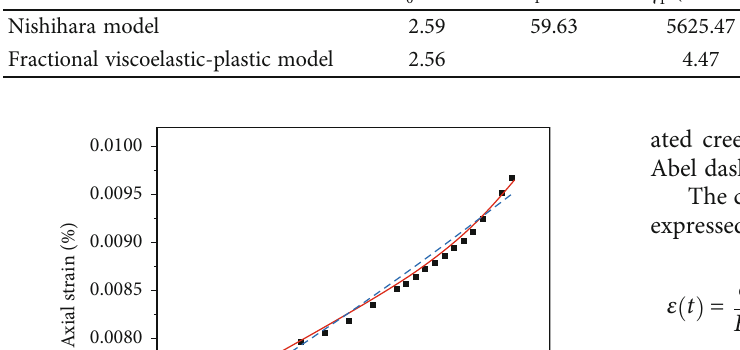
Table 3: Parameters determined by fi tting analysis based on creep test of mudstone interlayer ð σ ≥ σ Stress/MPa